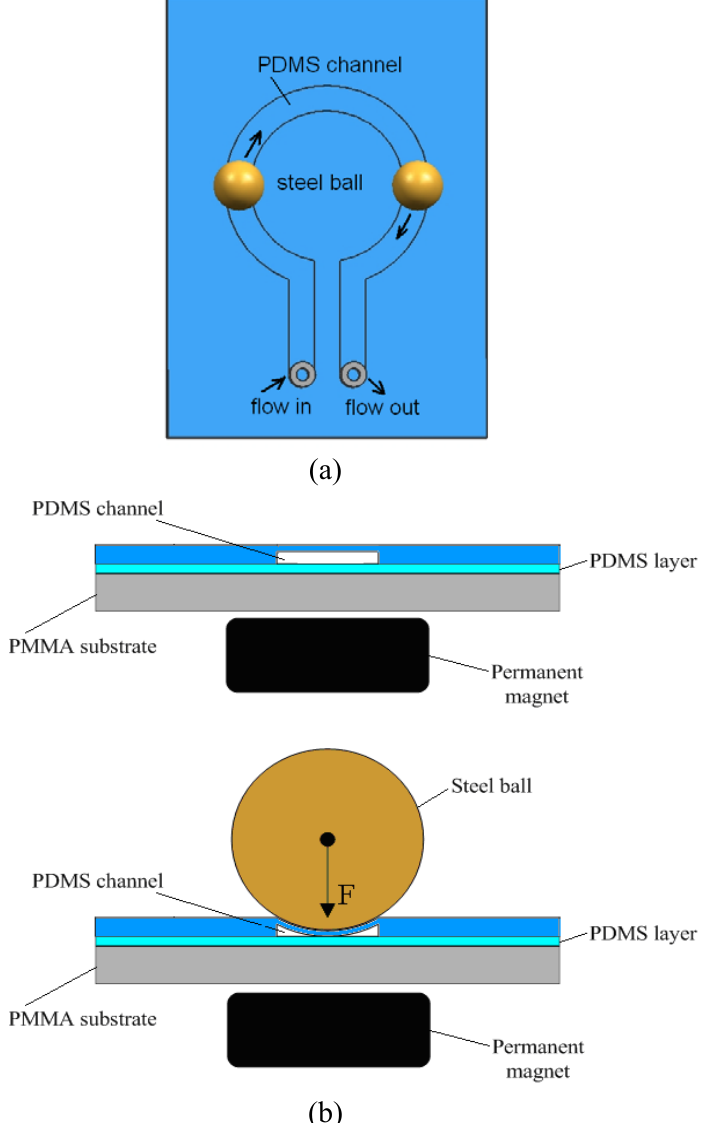
Figure 1. Schematic of the peristaltic micro pump (a) top view; and (b) cross